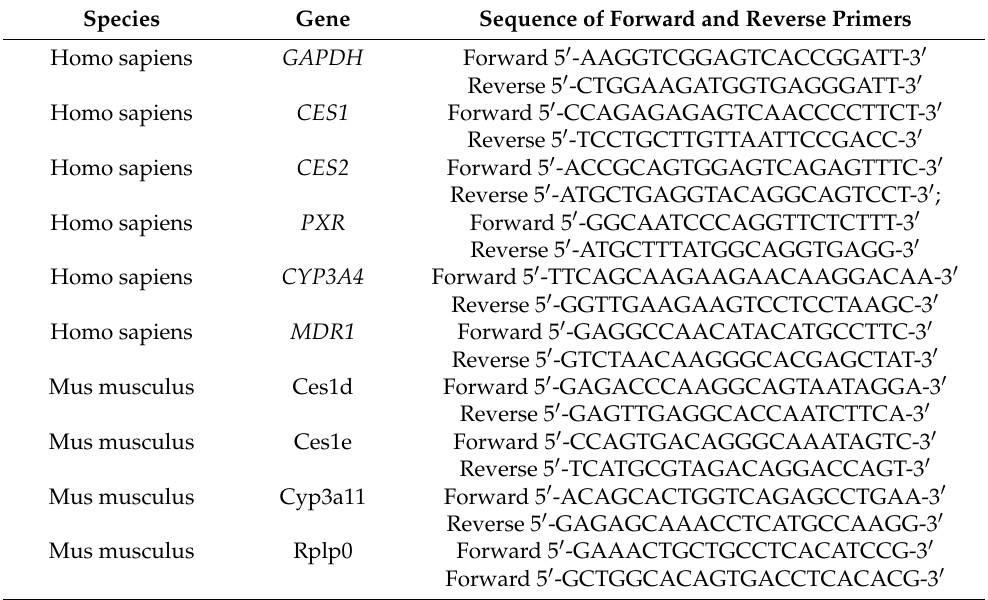
Table 1. Nucleotide Sequences of Gene-Specific Primers Used for Quantitative Real-Time PCR, Related to the Experimental